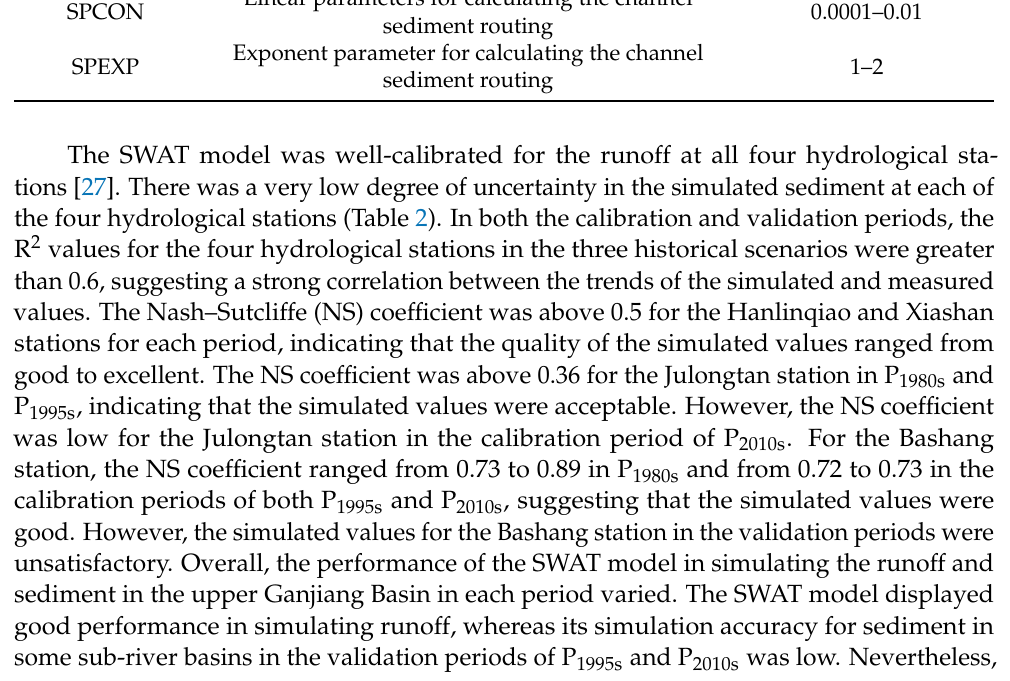
Linear parameters for calculating the channel SPCON Exponent parameter for calculating the SPEXP